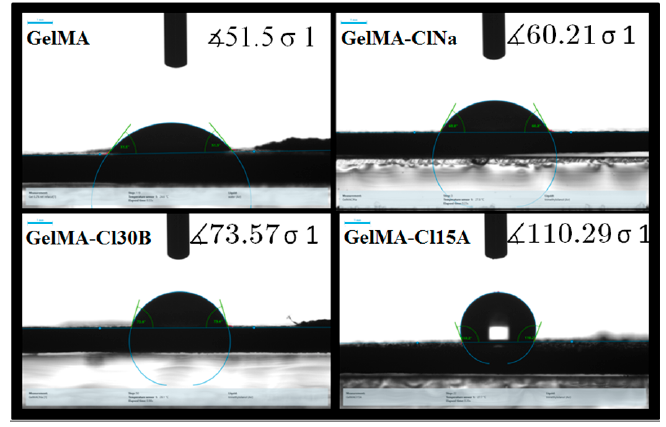
Figure 9. Water contact angle measurements for GelMA and GelMA-based samples.